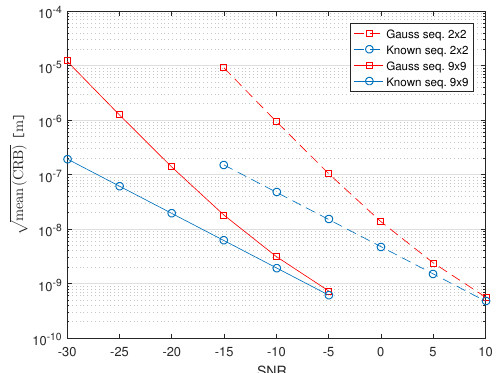
Figure 8. Dependence of the CRB, averaged over space, on SNR 0